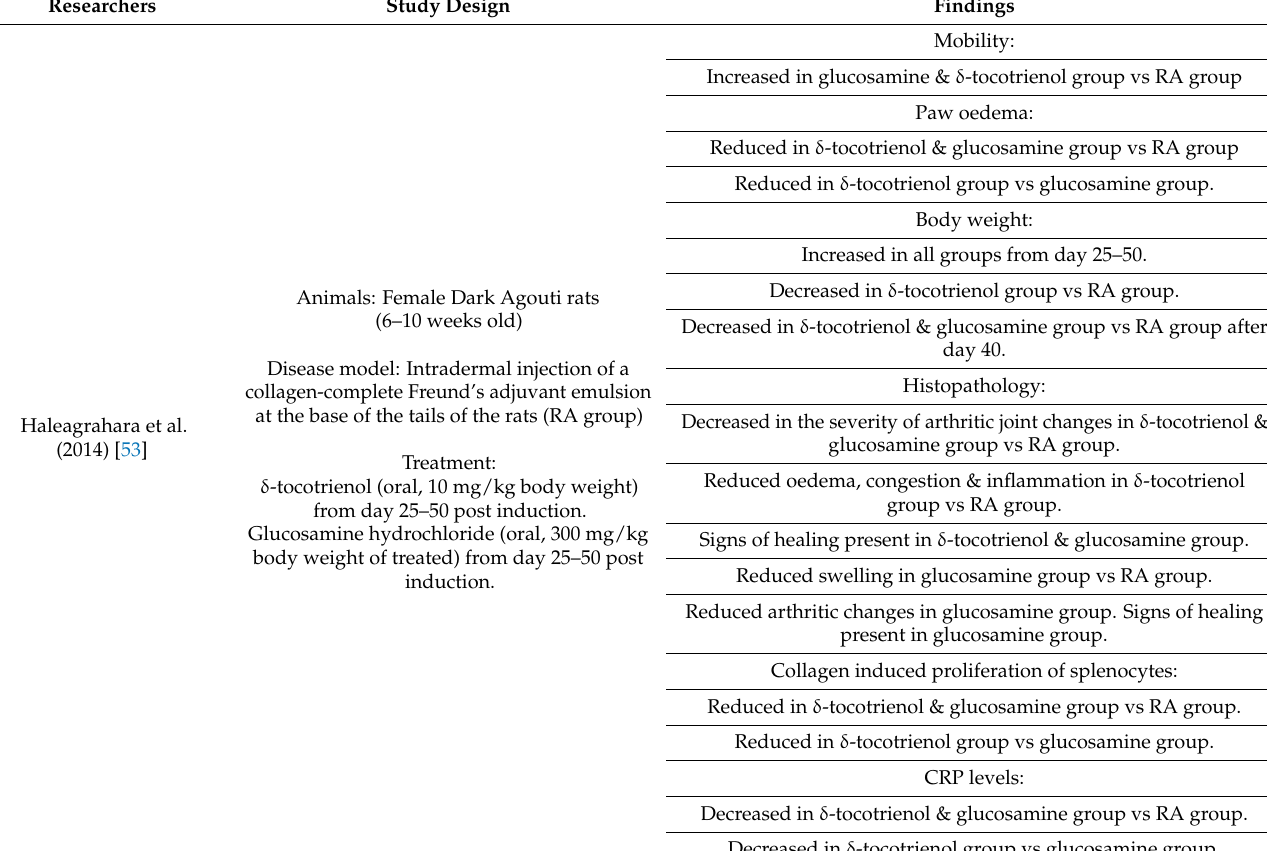
Table 2. The effects of tocotrienol on